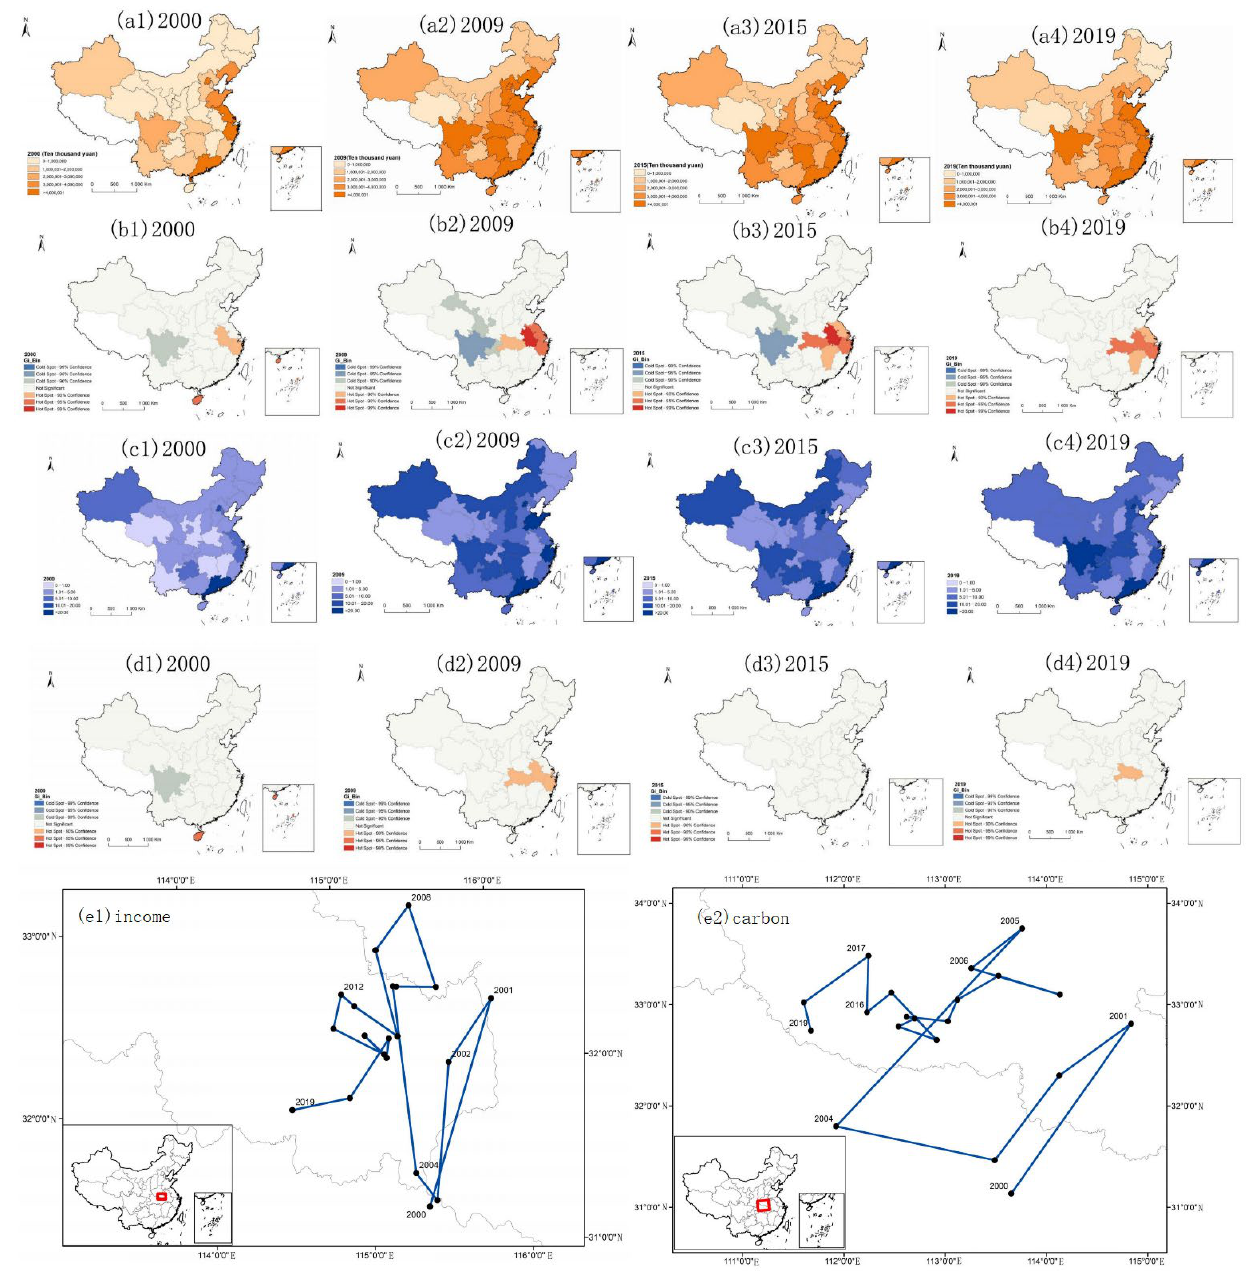
Figure 4. Spatial distribution characteristics and evolutionary trajectory of tourist hotel income and carbon emissions in China ( a1 – a4 ) is the spatial distribution chart of income in 2000, 2009, 2015, and 2019. The darker the color, the higher the income; ( b1 – b4 ) is the hot spot distribution of tourist hotel income; ( c1 – c4 ) is the spatial classification chart of carbon emissions, and the darker the color, the more serious the carbon emissions are. ( d1 – d4 ) are hot spots of carbon emissions in tourist hotels; ( e1 ) is the shift track of the income center of China’s tourist hotels from 2000 to 2019, and ( e2 ) is the shift track of the carbon emission center of China’s tourist hotels from 2000 to 2019. The red square indicates the position of the center of gravity in China.